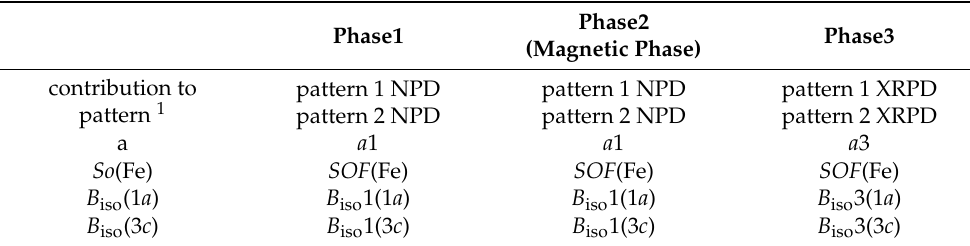
Table A5. Set constraints of the simultaneous Rietveld refinement of FePd 3 ( Pm 3 m ) based on NPD (Figure 2) and XRPD data (Figure A1) using FullProf